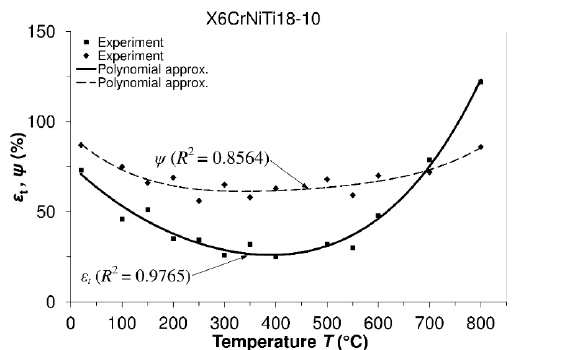
Figure 3. Dependence of mechanical properties on temperature: X6CrNiTi18-10 steel. ( a ) Ultimate tensile strength ( σ m ) and 0.2 offset yield strength ( σ 0.2 ) versus temperature; ( b ) The modulus of elasticity ( E ) versus temperature; ( c ) Total elongation ( ε t ) and reduction in the area ( ψ ) versus temperature.